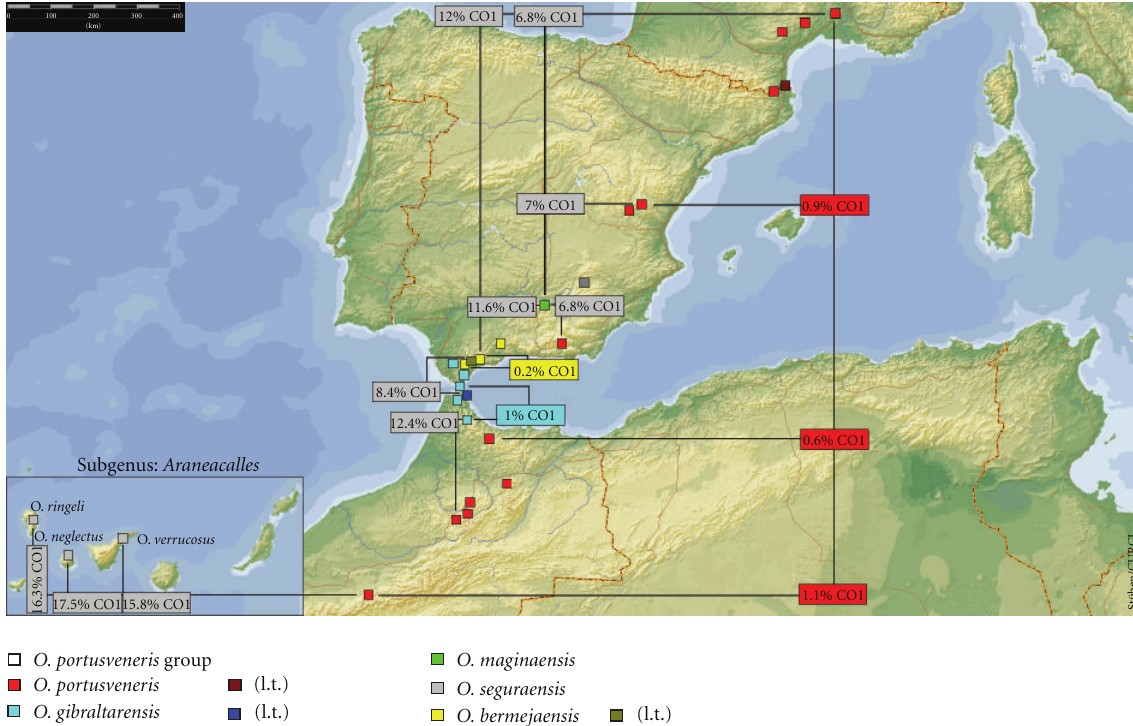
Figure 4: Distribution of related species of the O. portusveneris group in the Mediterranean area with values of COI p-distance